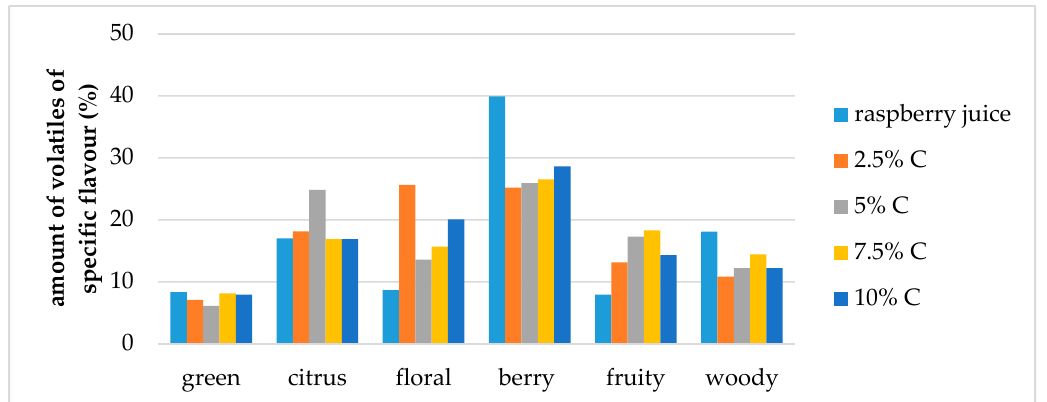
Figure 6. Amount of volatiles of specific flavor profile of raspberry juice and cellulose/raspberry complexes prepared by 60 min complexation (C—cellulose).